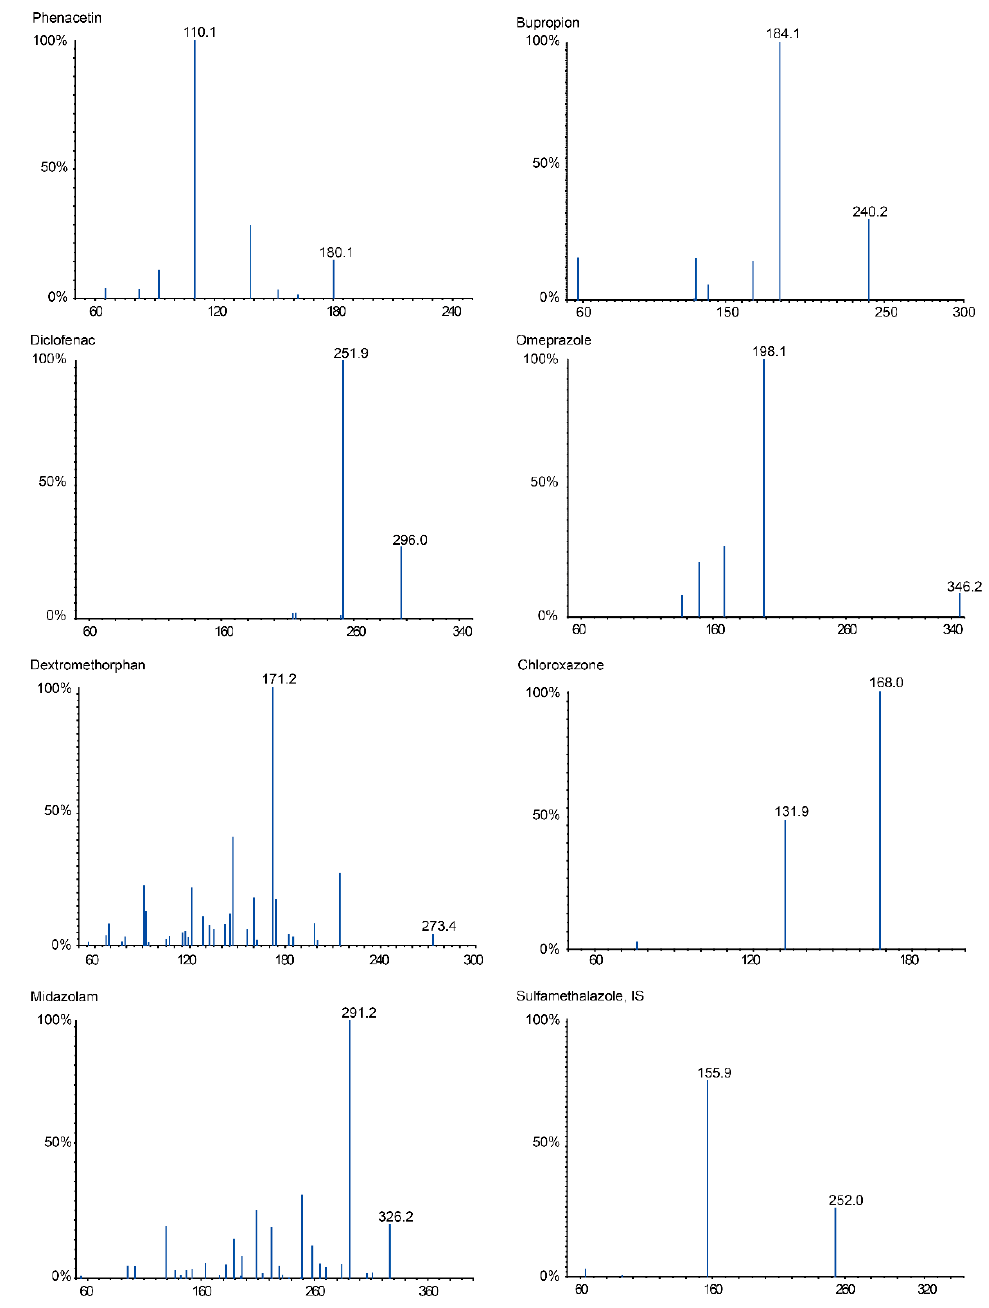
Figure 1. The MS/MS spectra of seven analytes and IS in positive and negative ion mode. Table 1. MRM parameters for probe drugs and internal